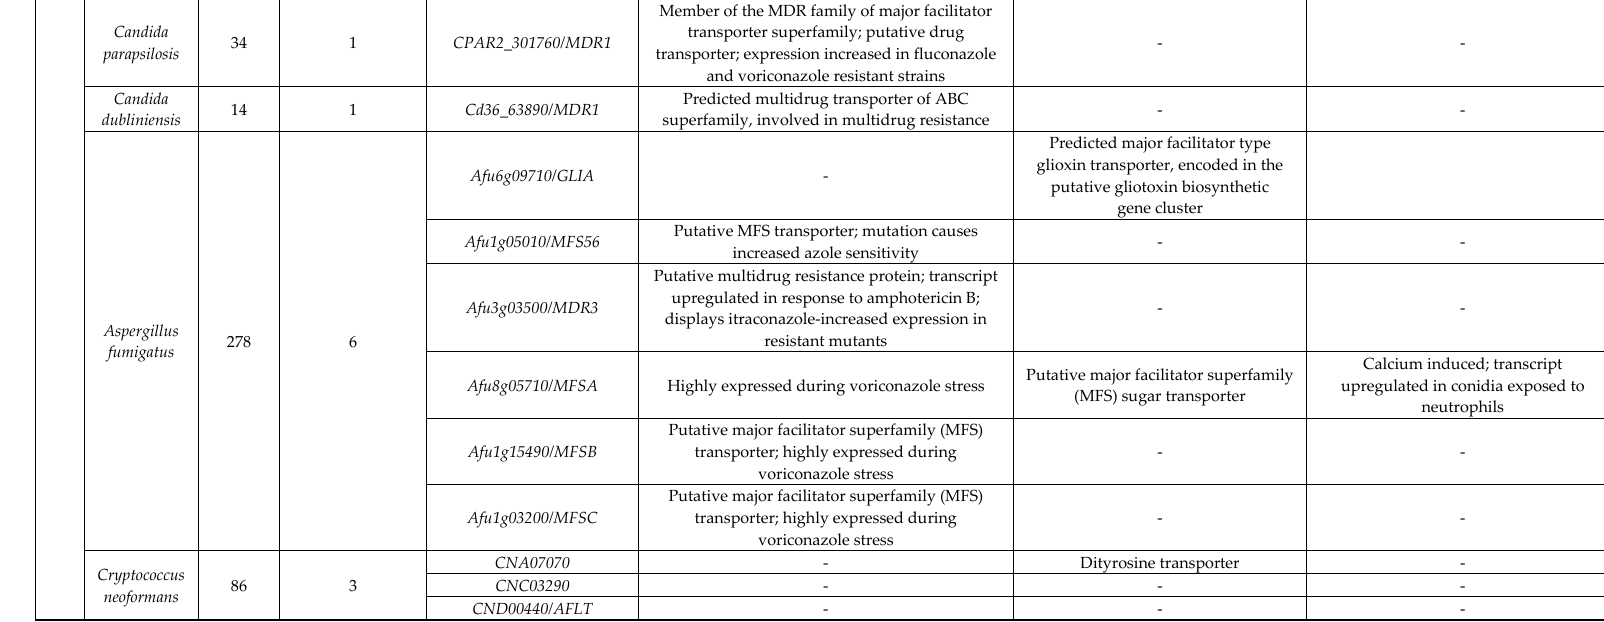
Genes 2018 , 9 , x FOR PEER